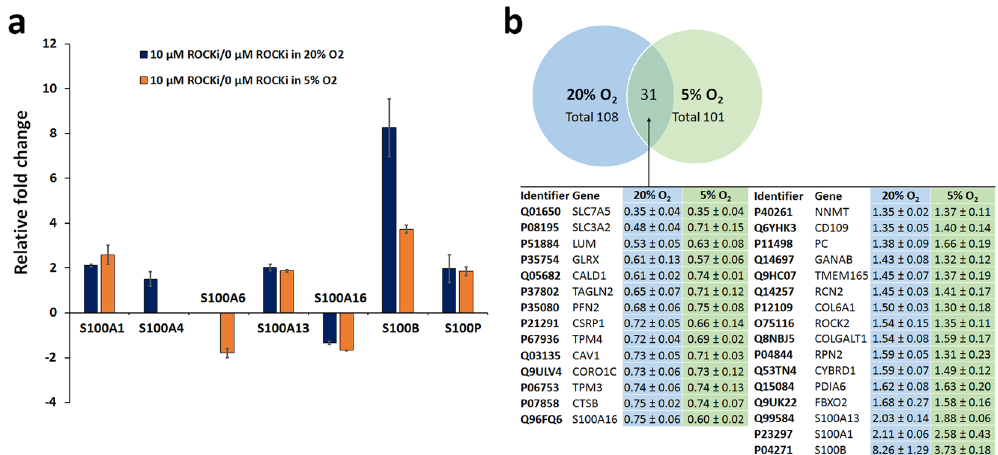
Figure 4. Long-lasting Y-27632 treatment produced several S100 protein fold changes in HCS-2/8 cells ( a ). Y-27632 increased S100-B expression the most. The second highest up-regulated S100 protein was S100-A1 although, S100-A13 and S100-P were relatively close to this increase. Y-27632 down-regulated S100-A16 expression and both S100-A4 and S100-A6 proteins had oxygen-dependent regulation. The Venn diagram depicts the internecine protein fold changes produced by the Rho-kinase inhibitor Y-27632 at normoxia and at hypoxia ( b ). A long-lasting 10 µ M Y-27632 exposure induced 31 oxygen-independent protein responses in human HCS-2/8 cells. The internecine fold changes are represented only for proteins that reached an ANOVA p -value equal to or less than